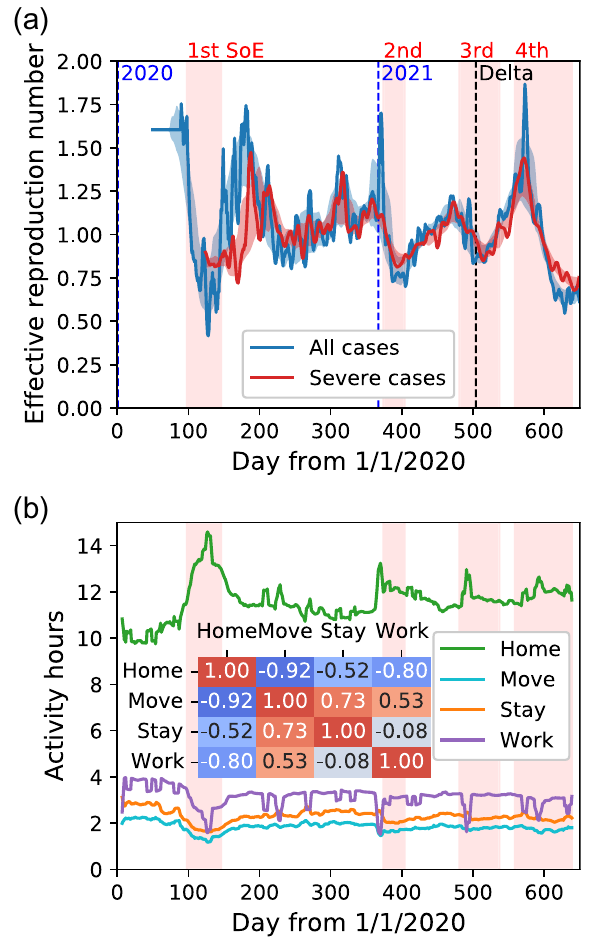
Figure 1. ( a ) Effective reproduction number of all infections and severe cases in the Tokyo metropolitan area. The SoEs and beginnings of years are also shown. The first case of the Delta variant in Japan is represented as ‘Delta’. Severe cases are plotted, taking into account the 12-day delay. The light-colored range is estimated as follows. The centre of the range is the 31-day moving average of the original time series, and the range width is the 31-day moving average of the absolute difference between the centre and original time series. Before 30 Mar. 2020, the effective reproduction number is estimated using an average of 40 days because the confirmation of infection is not considered comprehensive. ( b ) Time series of mean duration per day of each activity in the Tokyo metropolitan area. The 7-day moving average is taken. The 1st–4th SoEs are also shown. The Pearson’s correlation among the mean duration of the four activities in the span 200 ≤ t < 500 is